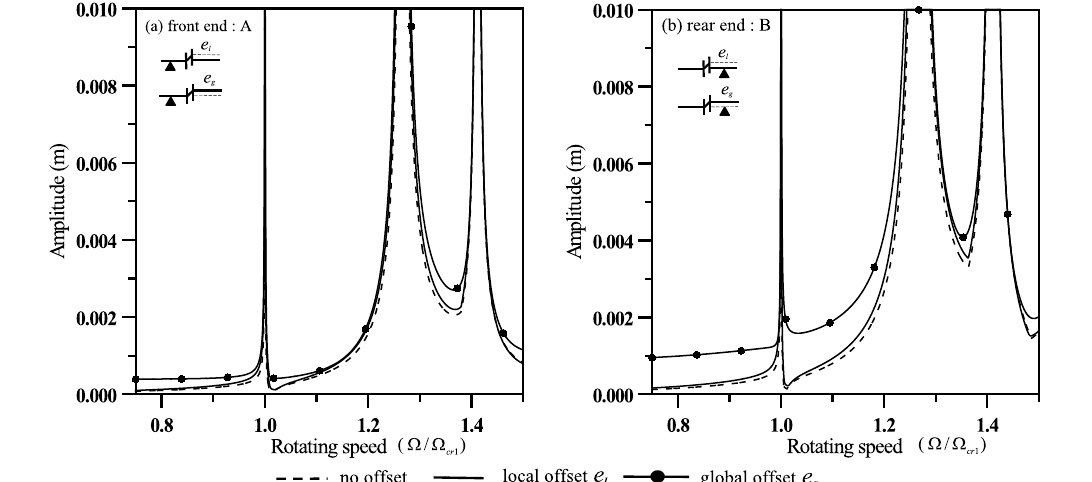
Fig. 8. FRF due to disk imbalance and offset (a) at station 12, and (b) at station